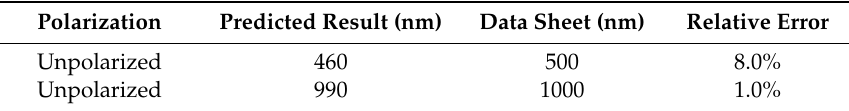
Table 3. Overview of polystyrene size characterization